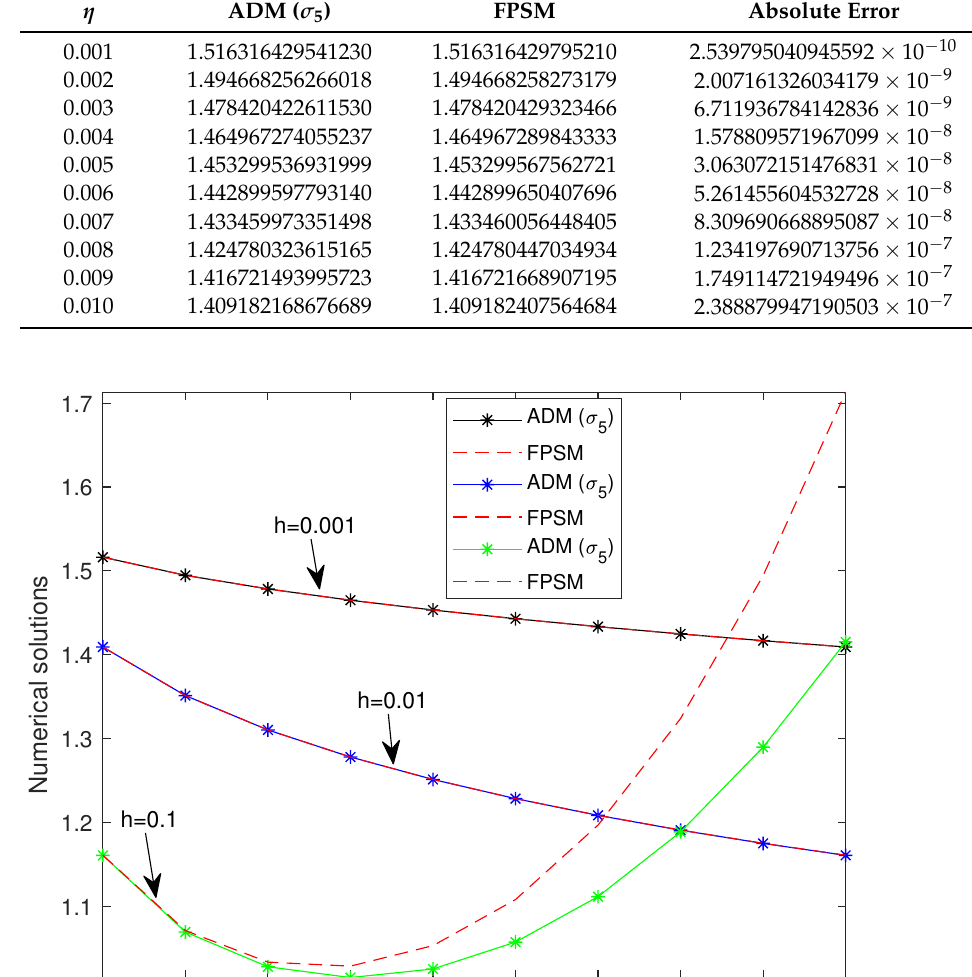
Table 4. Comparison of numerical solutions and absolute errors for Equation (35).